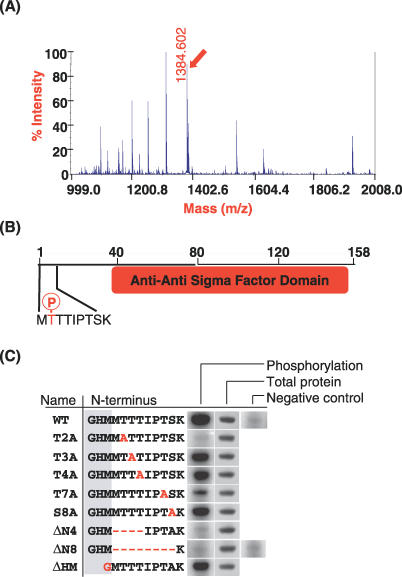
PknD Phosphorylates Rv0516c on Thr2 In Vitro(A) Mass spectrometry of trypsin-digested, PknD-phosphorylated Rv0516c indicated the presence of a single phosphorylation site within the N-terminal nine residues. The figure shows the mass spectrum of an HPLC fraction of the digest. The measured mass (monoisotopic MH+) of the N-terminal peptide (1384.60 Da [arrow]) was 79.97 Da larger than the expected mass of 1,304.63 Da, corresponding to addition of a single phosphate group. Tandem MS and N-terminal sequencing of the peptide at m/z 1,384.60 revealed Thr2 as the site of phosphorylation.(B) Rv0516c Thr2 occurs in a unique, 28-residue Ser/Thr-rich, N-terminal extension, not in the anti-anti–sigma factor domain.(C) Mutations in the N-terminus of Rv0516c confirm that PknD phosphorylates Rv0516c on Thr2. The eight indicated mutants of Rv0516c were purified, and in vitro phosphorylation by the PknD kinase domain was assayed after cleavage with the TEV protease (left). Non-native residues before the start of Rv0516c left after TEV protease cleavage are shaded in gray. Protein-stained loading controls (center) confirmed that an equal amount of each Rv0516c variant was assayed. Controls lacking kinase showed that the phosphorylation was due to PknD (far right). Thr2Ala (T2A) and deletions of the N-terminal four and eight residues caused the most dramatic reductions in phosphorylation.